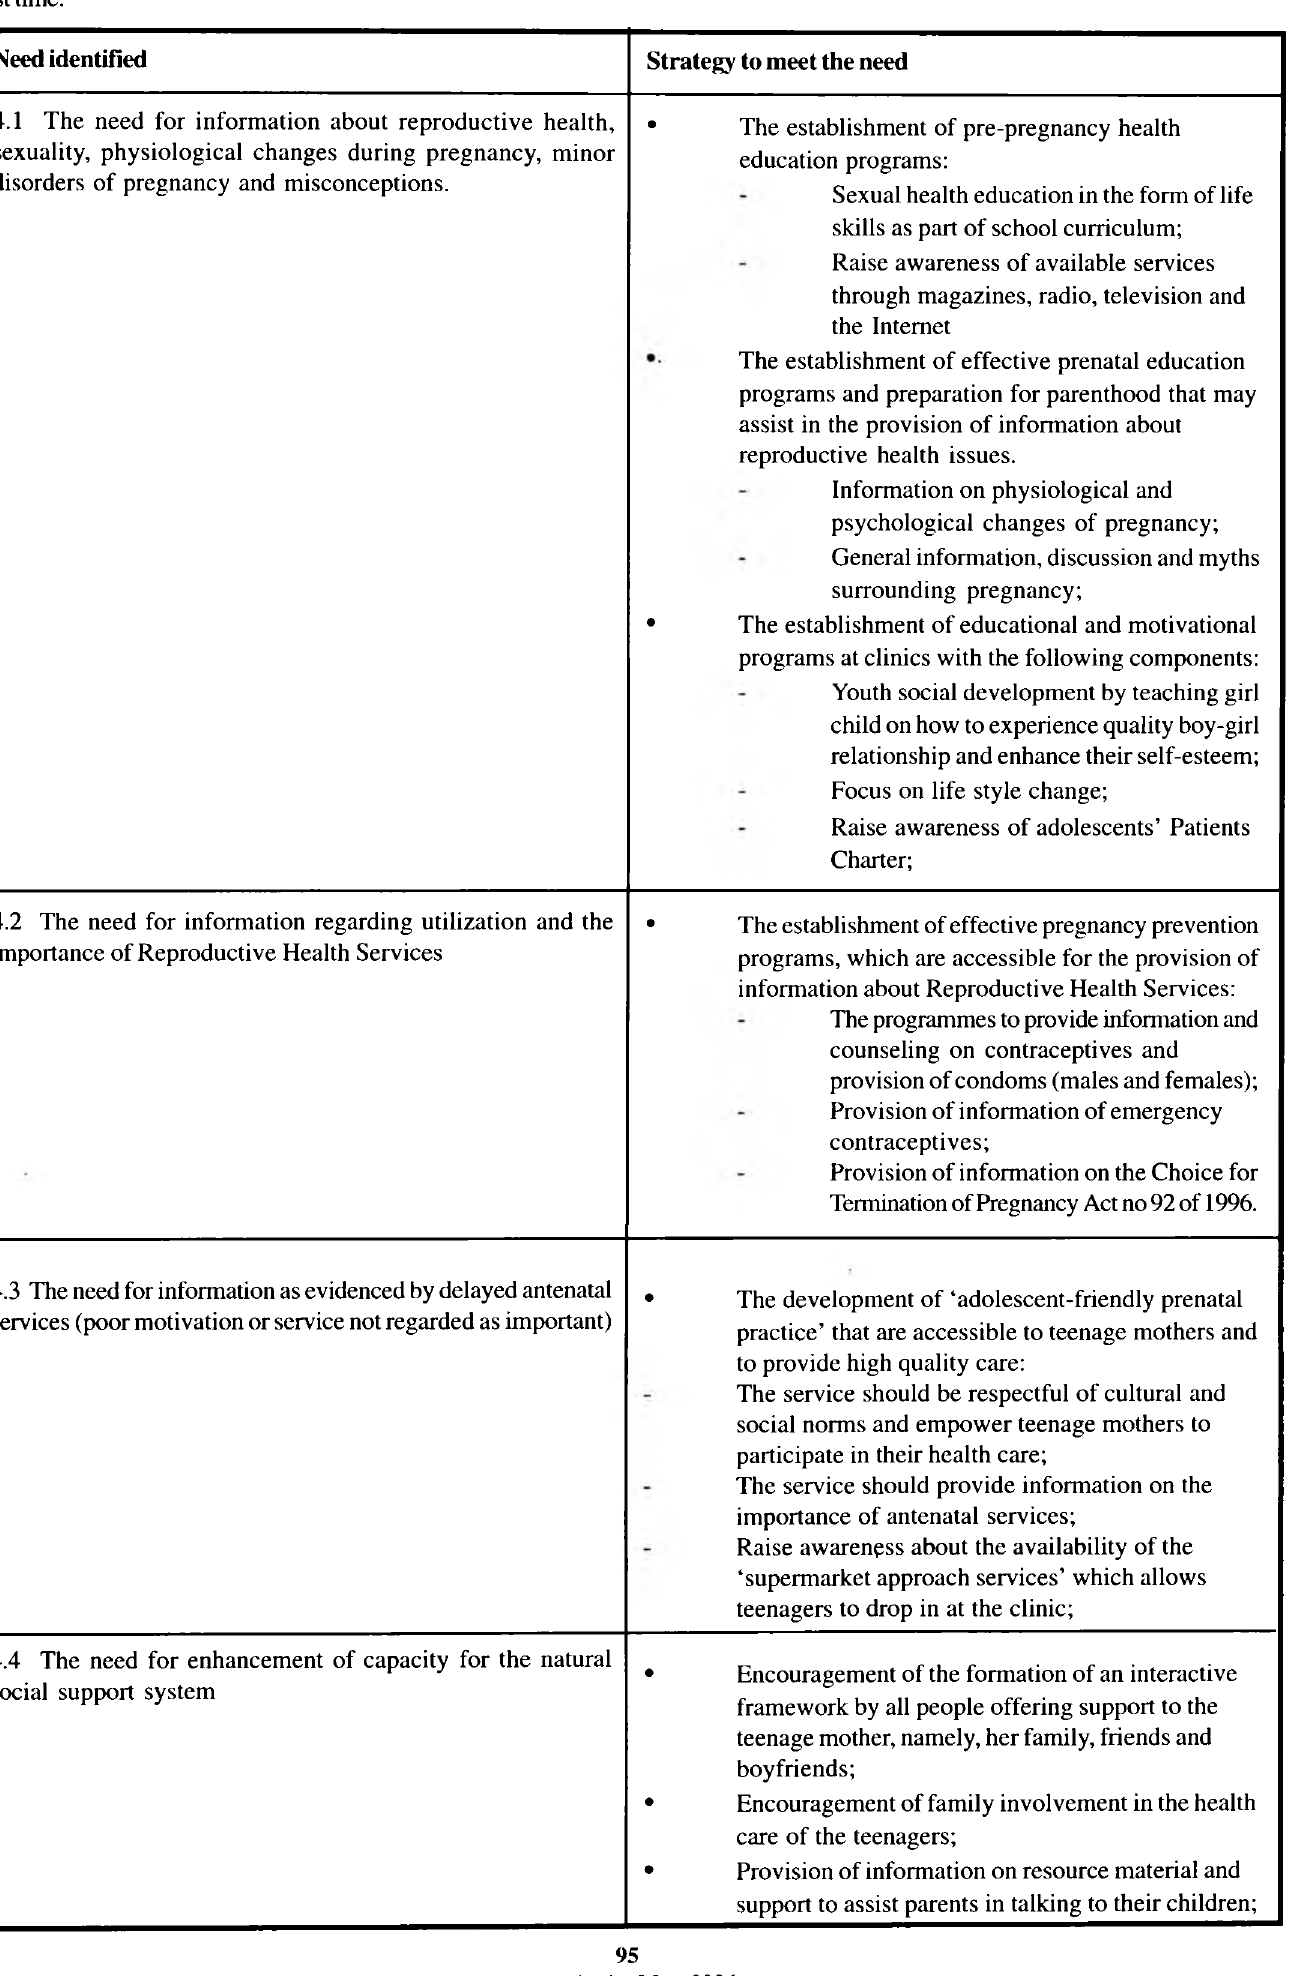
Table 2: Guidelines of the support programme for pregnant teenagers The guidelines were developed as possible strategies for meeting the identified needs of teenage mothers who are pregnant for the first